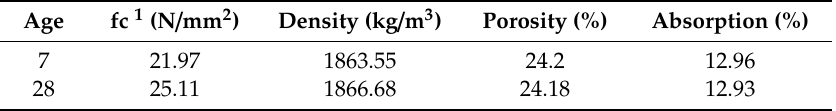
Table 3. Mechanical properties of sprayed mortar.